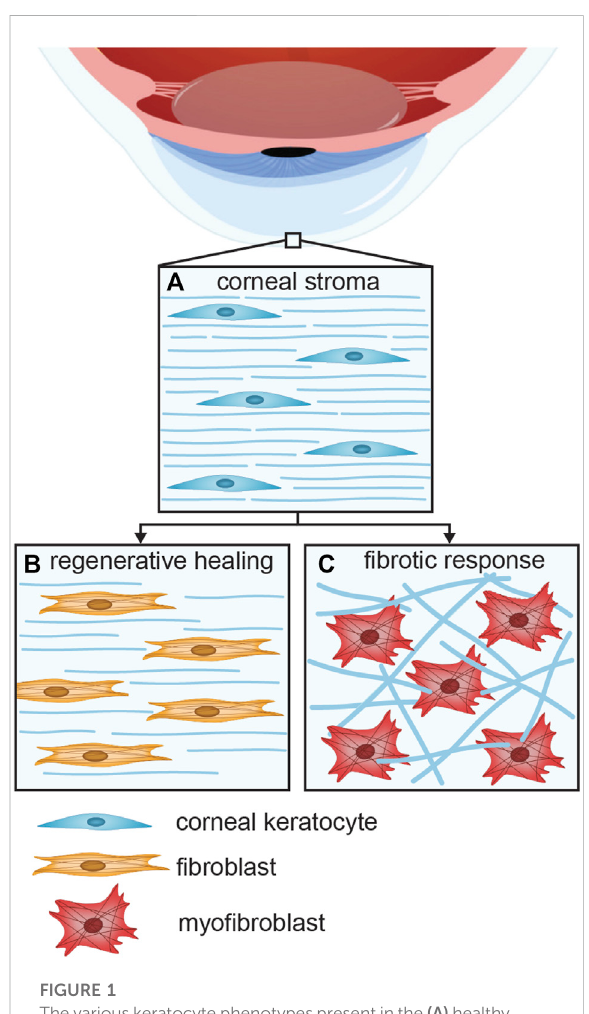
FIGURE 1 The various keratocyte phenotypes presentinthe (A) healthy, (B) regenerative, and (C) fi brotic corneal stroma. Activation of normally quiescent keratocytes leads to the differentiation of fi broblasts that proliferate and migrate towards the damaged area, where the ECM is regenerated. Hyperactivation of keratocytes may lead to a fi brotic